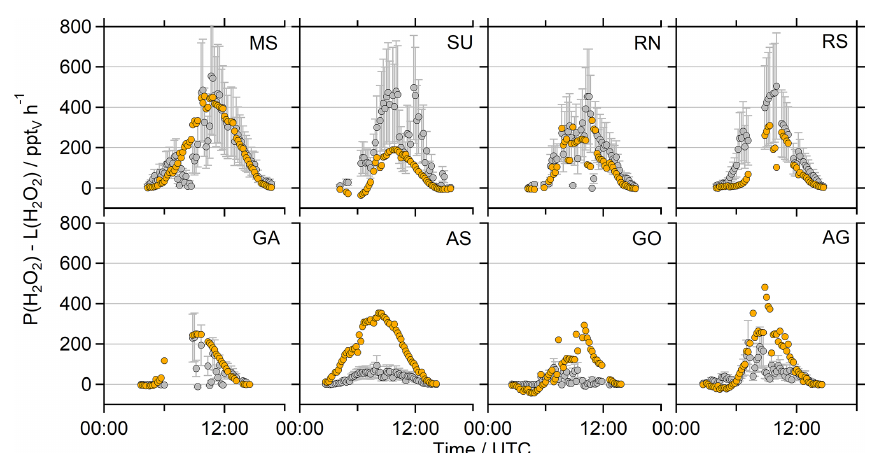
Figure 8. Diurnal variation in the net photochemical production of H 2 O 2 ( P (H 2 O 2 )– L (H 2 O 2 )) of the observations (grey) and the EMAC ≥ 10 − 3 s − 1 ). The corresponding timelines are presented in Fig. S11. Note that the deposition model results (orange) during the day ( j NO 2 term from Eq. (4) is not included in this calculation.